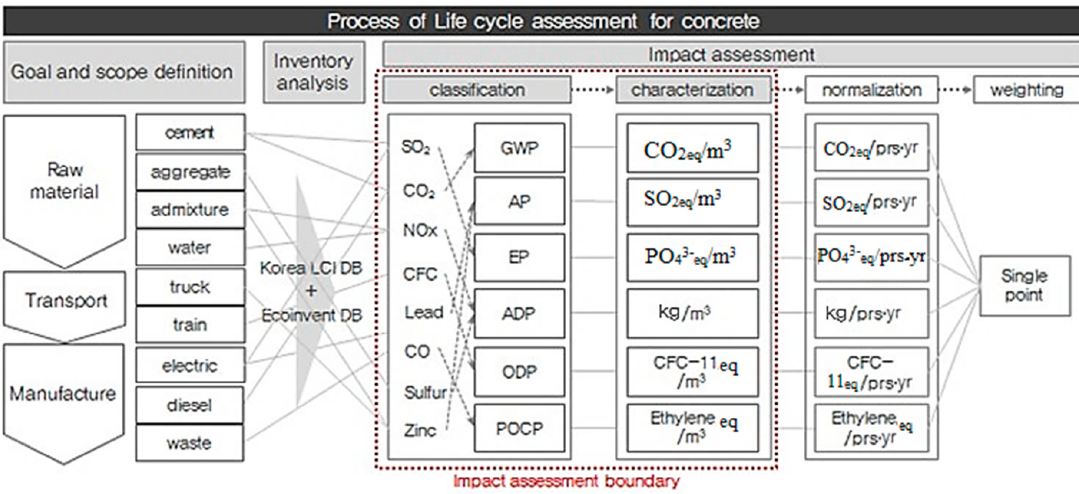
Figure 2. Process of Environmental impact assessment for Concrete.